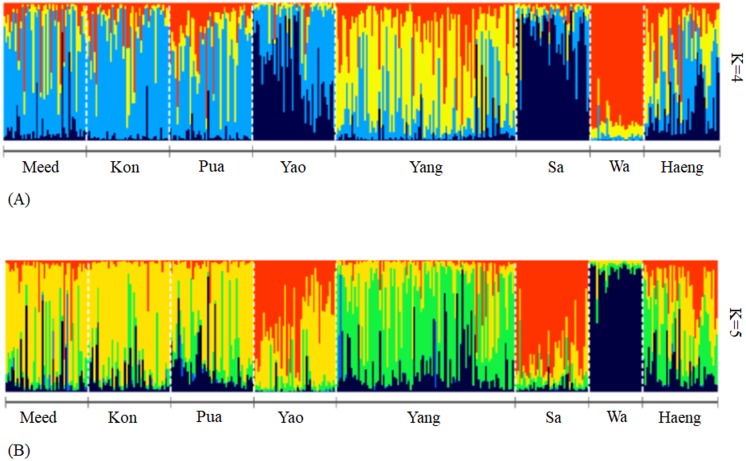
Bar plot of membership coefficients of individuals assigned to genetic clusters (K = 4 and 5) generated by a Bayesian clustering algorithm, implemented in the TESS software.The individual coefficients (vertical bars) were grouped by population samples. Membership to each cluster is represented by a different color. The bar plot illustrates (A) four and (B) five genetic clusters.